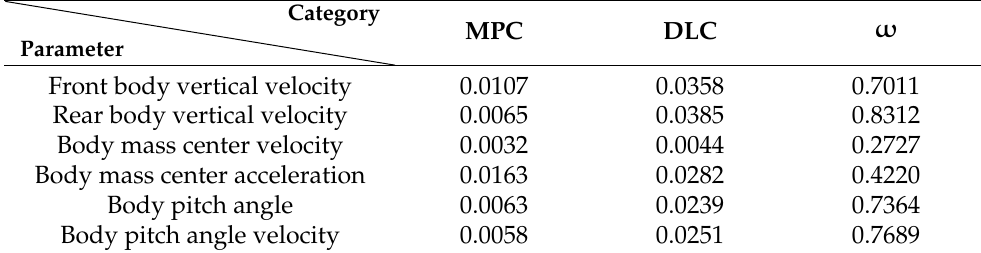
Table 2. Root mean square ( RMS) of some parameters.